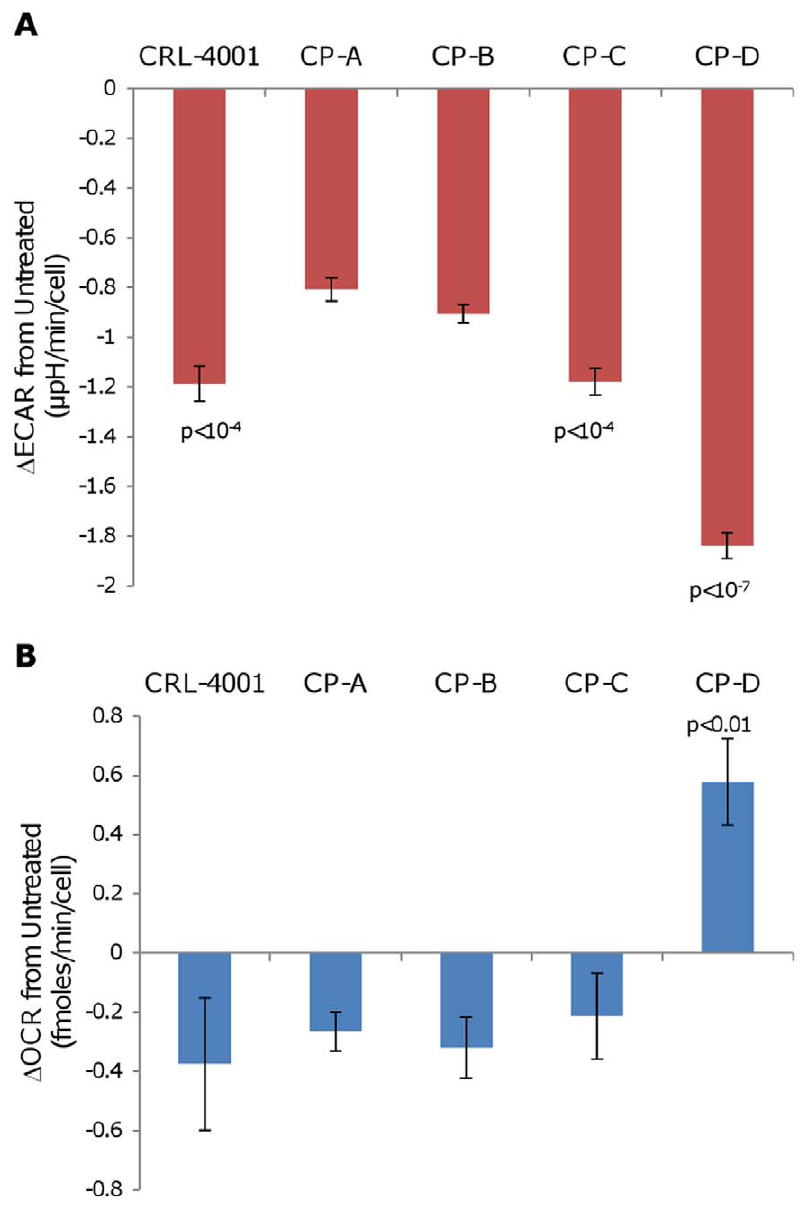
Error bars represent standard-deviation of means between experiments (N=2–4). Each experiment consisted of 3–4 replicate wells per cell line with four serial measures performed on each well. p-values (Tukey-Kramer test) of statistically significant differences from CP-A are